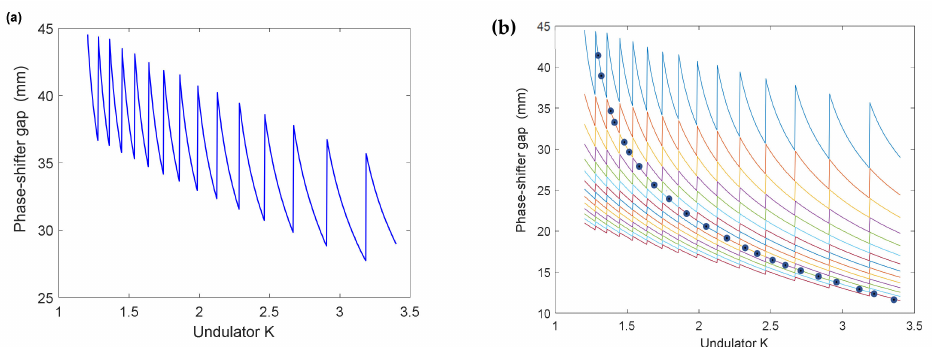
Figure 7. Phase-shifter gap distance as a function of undulator K found with ( a ) n = 1 and ( b ) n = 1 to 14 at Equation (7). A continuous line is found in ( b ), consecutively connecting from n = 1 to n = 14, marked by